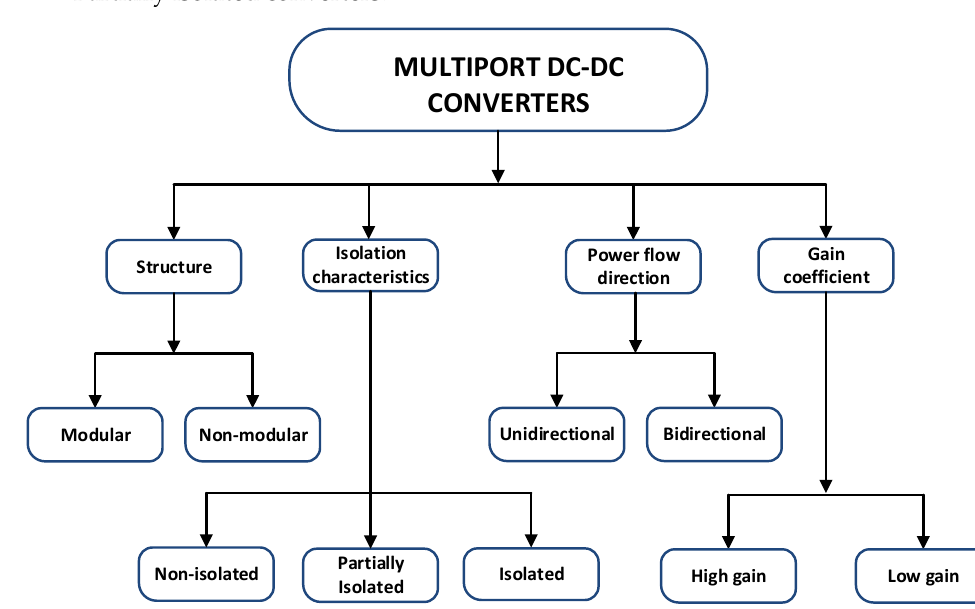
Figure 2. General classification of multiport converters.